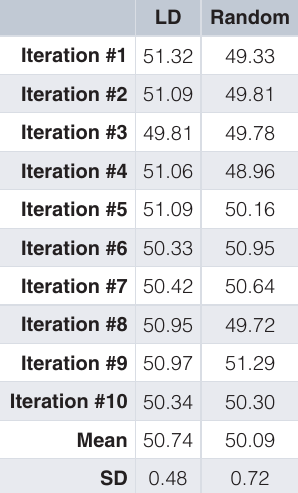
Table 1. Percentages of the classifications for the stimulated participants. LD: linear discriminant classifier; Random: random classifier.